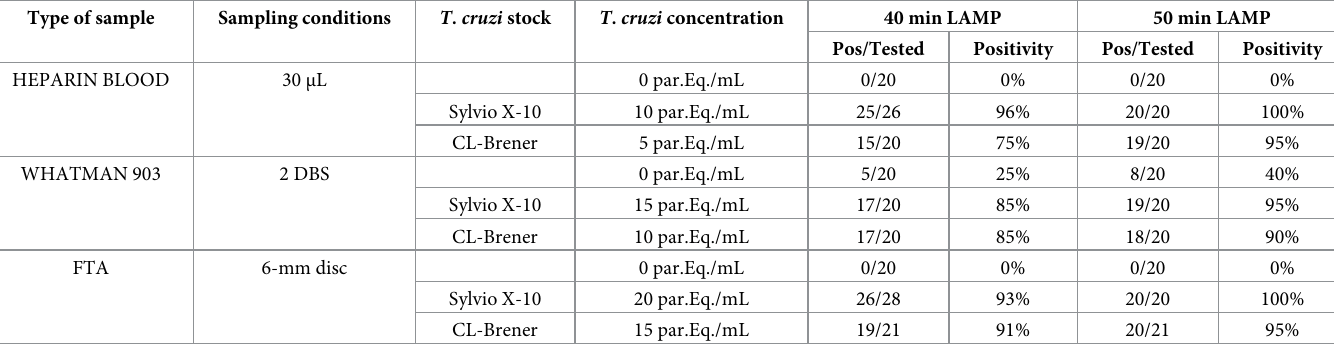
Table 1. Limit of detection of LAMP in fluid blood samples or DBS containing blood spiked with parasite stocks from two different